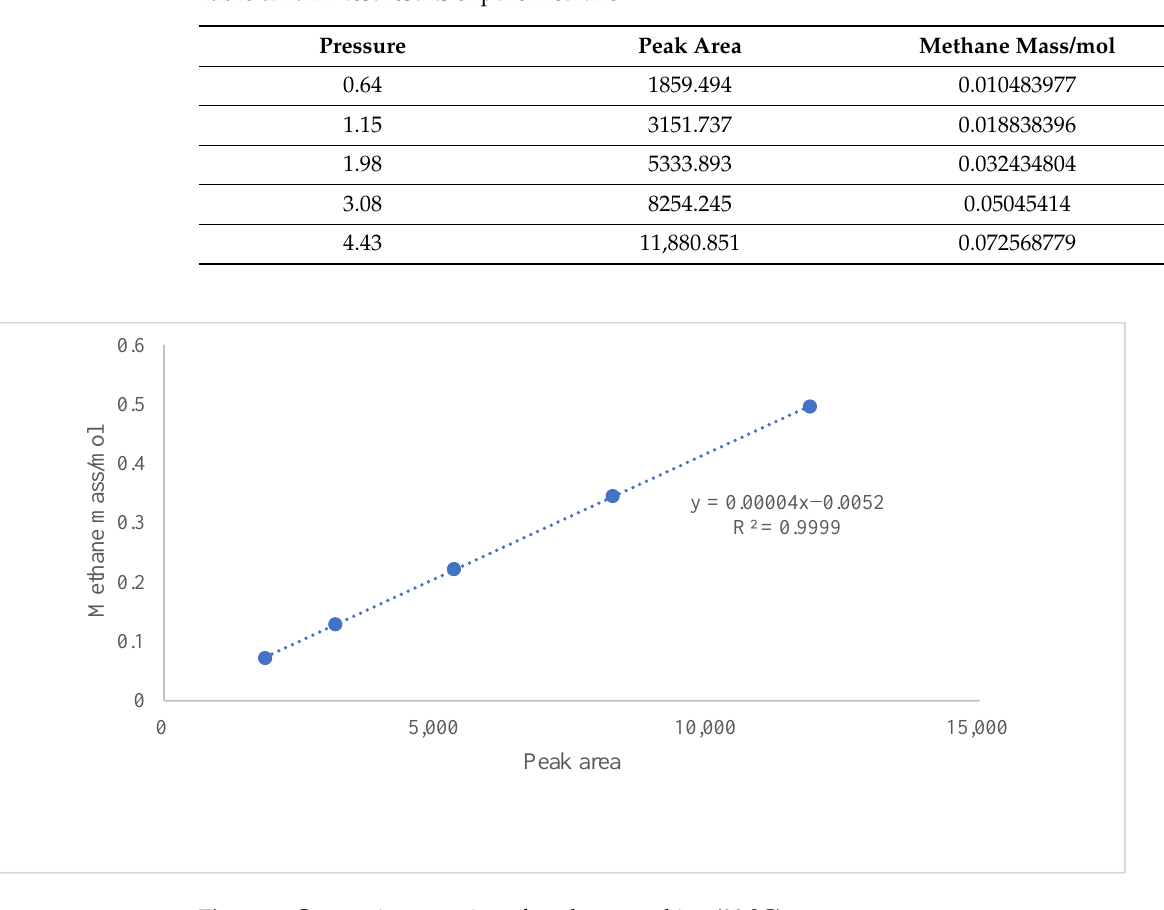
Figure 5. T 2 spectra of coal gas adsorption process modified by different surfactants under 0 – 2 MPa pressure. As can be seen from Figure 5 and 6, the T 2 spectral curve in the process of coal sample gas adsorption had a three-peak structure, marked as Q 1 , Q 2 and Q 3 from left to right, and the relaxation time was around 0.1~1 ms, 10 ms and 100~1000 ms. Combined with the test results of the free-state gas NMR spectra in Figure 4, it can be determined that Q 1 , Q 2 and Q 3 represent the adsorption, free and free gas spectra peaks, respectively. In the low-pressure range of 0 – 2 MPa, combined with the nuclear magnetic T 2 spectra in Figure 5, it can be seen that the peak signal amplitude of Q 1 of coal samples treated with tea saponin was the largest, while that of coal samples treated with SDBS was the smallest.